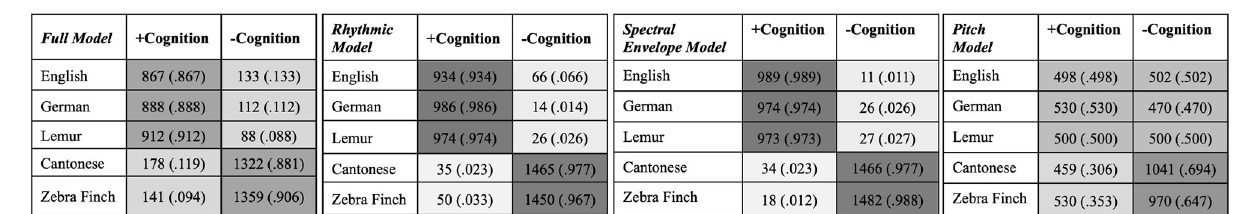
FIGURE 2 | Confusion Matrices: classification of English, German, Lemur, Cantonese, and Zebra Finch vocalizations into classes of vocalizations that do (+Cognition) and do not (-Cognition) support object categorization.